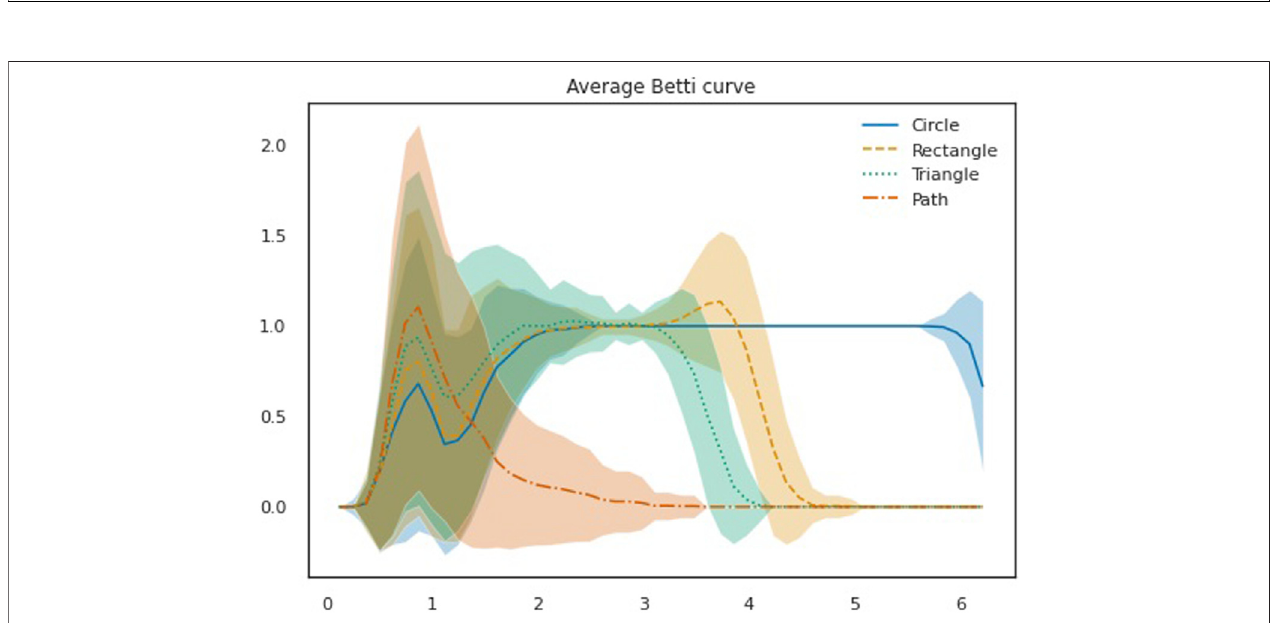
FIGURE 6 | Average 1-st homology Betti curve for each shape (shaded area: standard deviation).